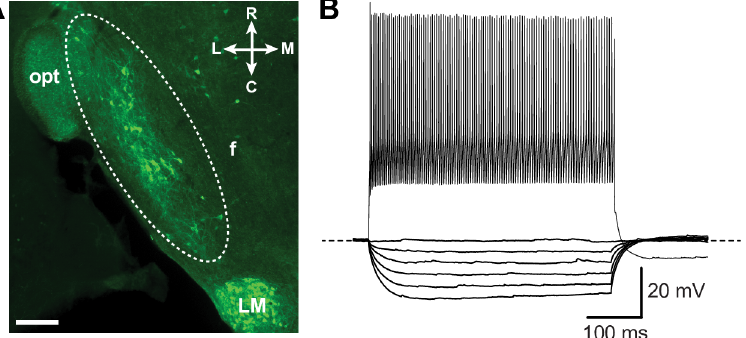
Fig 1. LH PV neurons exhibit fast-spiking characteristics. (A) Immunohistochemical identification of parvalbumin- expressing neurons in a horizontal section of the mouse LH. Dotted lines highlight a cluster of immuno-positive LH PV neurons (green). Scale bar, 200 μm. (B) Representative traces and firing pattern of a fast-spiking LH PV neuron in response to step hyperpolarizing (bottom traces; from − 100 to 0 pA) and depolarizing current injections (upper traces; 900 pA) during a 500 ms pulse. Resting membrane potential (V rmp = −66 mV) and maximal firing frequency 264 Hz. Abbreviations, fornix (f), optic tract (opt), lateral mammillary nucleus (LM), lateral (L), medial (M), rostral (R), and caudal